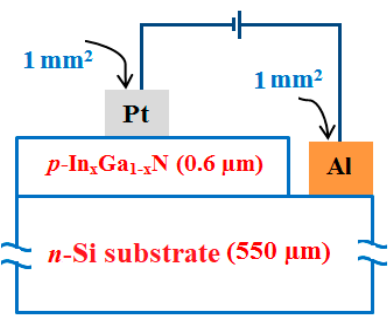
/ n– Si hetero junction